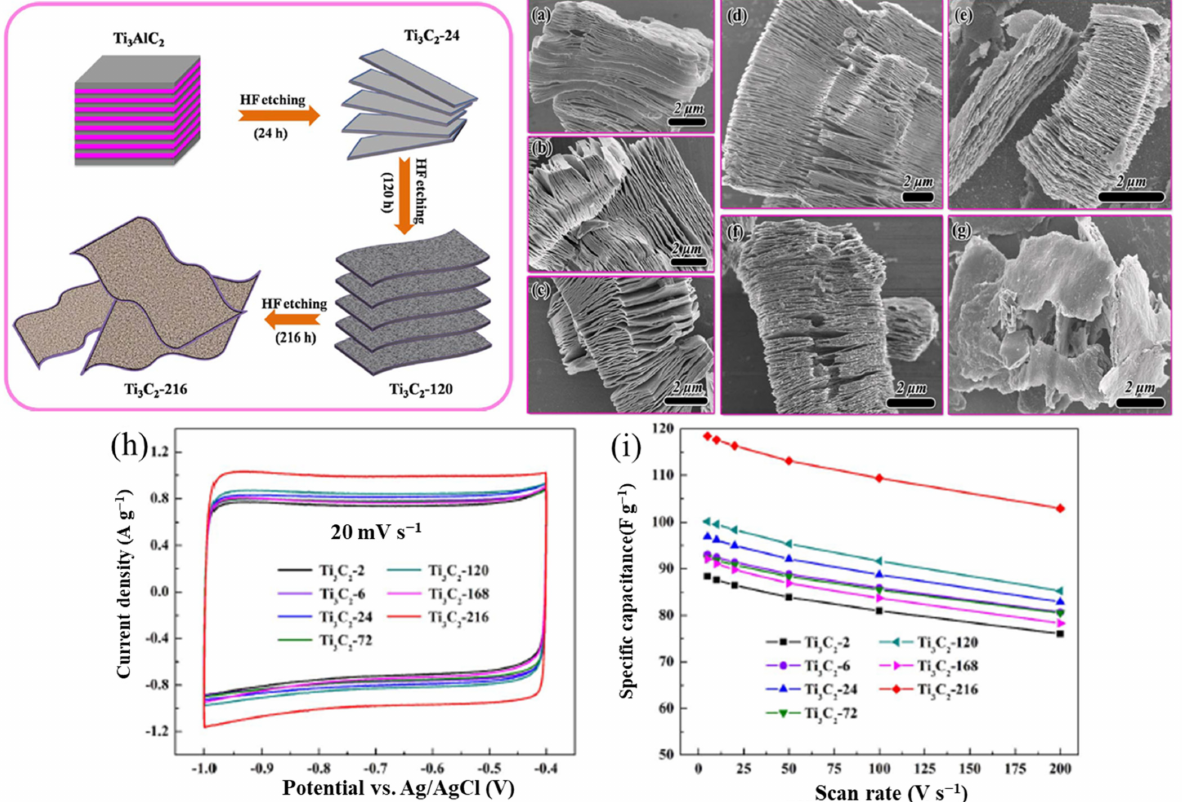
Figure 12. Schematic illustration of the typical structures of Ti 3 C 2 with the evolution of the etching time: SEM images of the typical as-fabricated MXene with the CV curves and specific capacitance vs. scan rate for the electrodes with different etching times